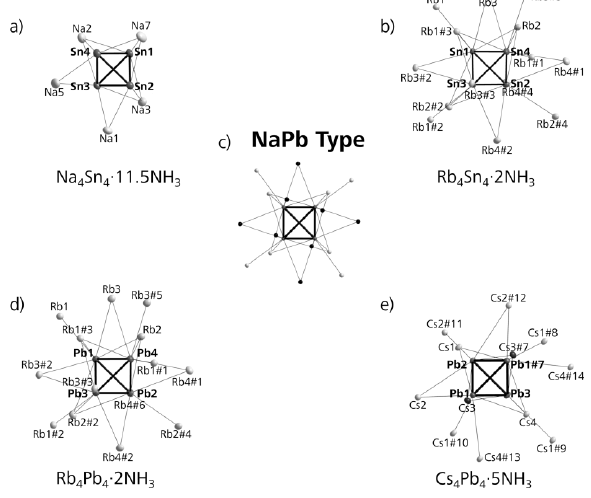
Figure 4. Section of the structure of Cs 4 Pb 4 ·5NH 3 ; corrugated Cs + -NH 3 strands along the Figure 2. Comparison of the cationic coordination spheres of [E 4 ] 4 − (E = Sn, Pb) clusters in crystallographic b-axis; the chains are emphasized by bold lines; [Pb 4 ] 4‒ cages are located along the Na 4 Sn 4 · 11.5NH 3 ( a ); Rb 4 Sn 4 · 2NH 3 ( b ); NaPb ( c ); Rb 4 Pb 4 · 2NH 3 ( d ) and Cs 4 Pb 4 · 5NH 3 ( e ); probability strands; hydrogen atoms are omitted for clarity; probability factor: 79%. factor: 50%; dark grey marked cations occupy special Wyckoff